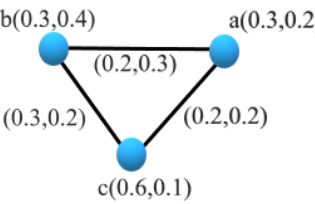
Figure 1. Intuitionistic fuzzy graph on three vertices.